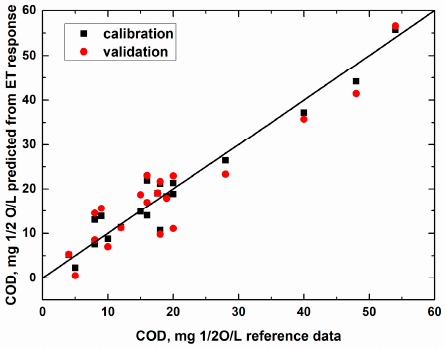
Figure 6. Measured vs. predicted plot of the PLS regression model for COD of natural water samples collected in India. Parameters of calibration/validation: slope 0.94/0.90; offset 1.07/1.61; RMSE 3.1/4.7; R 2 0.94/0.87. The model was based on four latent variables.